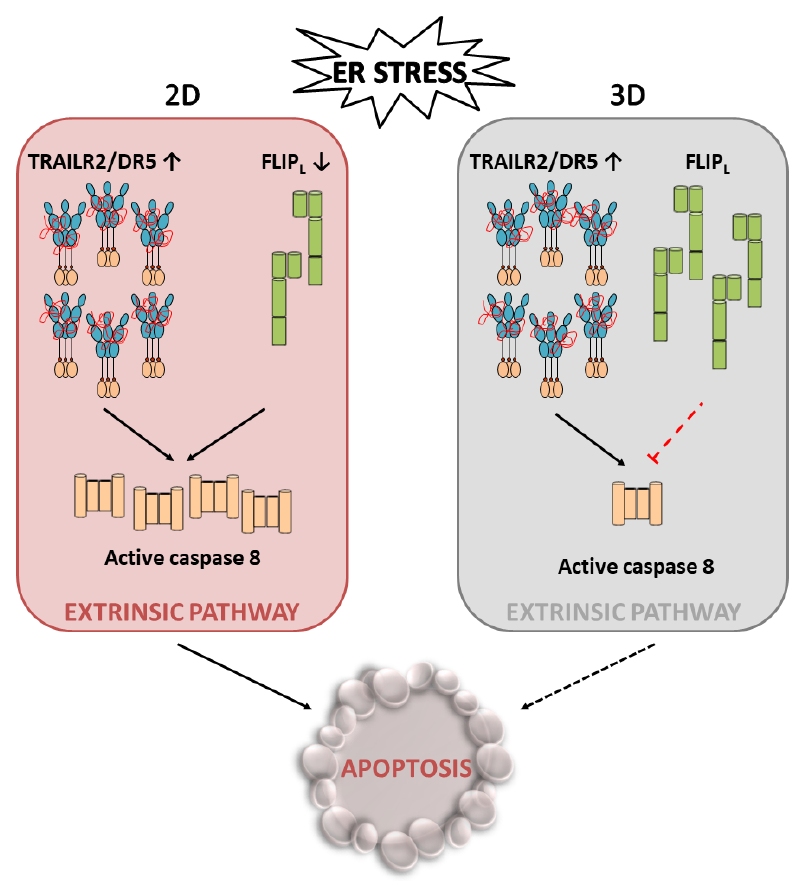
Figure 5. Schematic representation of the differential apoptosis induction between 2D and 3D cell cultures. Despite a similar increase in TRAIL-R2/DR5 levels in 2D and 3D cultures upon ER stress, FLIP levels are maintained in the latter, thus preventing caspase-8 activation of apoptosis.